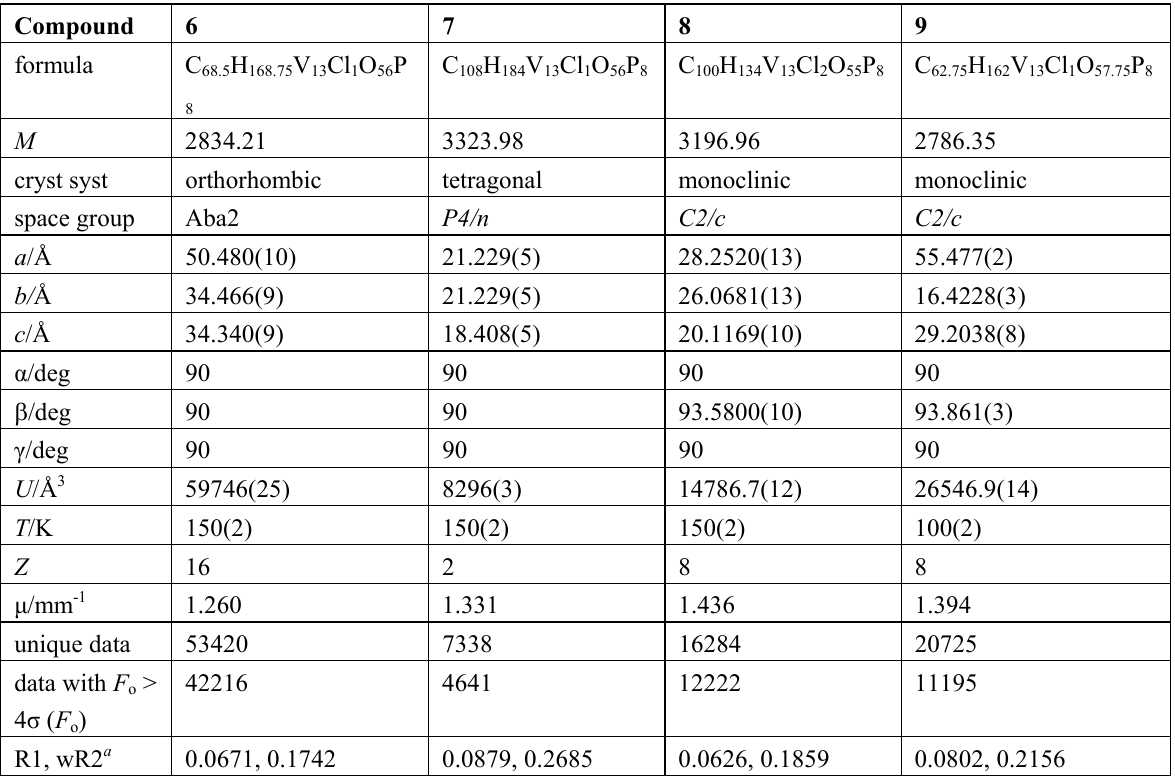
Table 2. Crystal data for